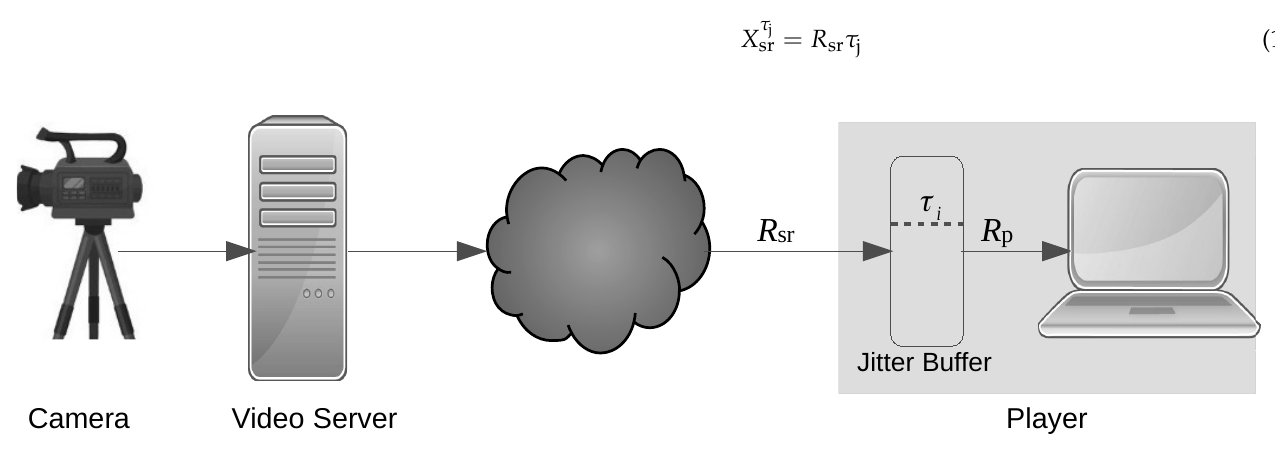
Figure 2. Video streaming